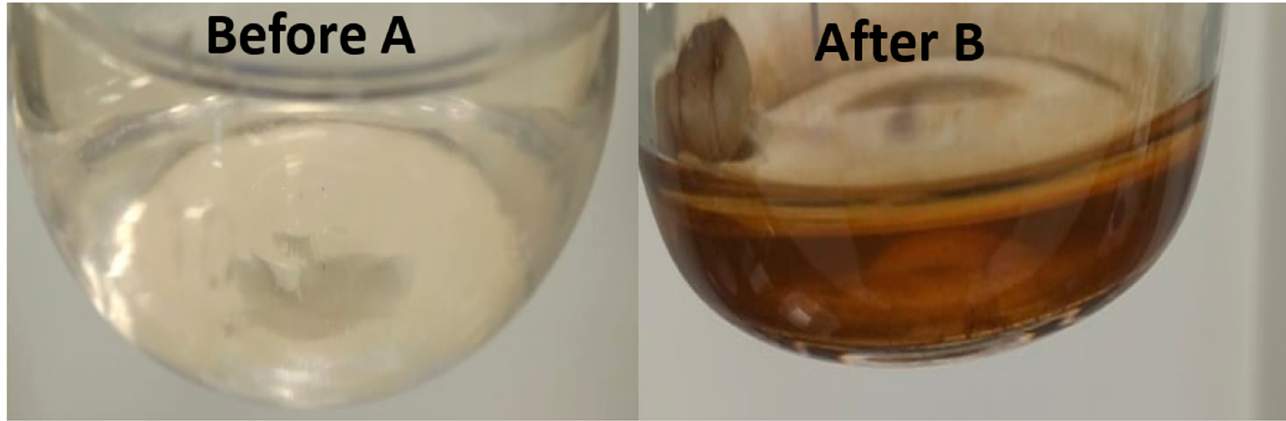
Figure 1. Flask A represents the color changes at time 0 ( before ) for AgNO 3 and propolis extraction, while Flask B represents the biosynthesis of AgNPs following 5 h ( after ).